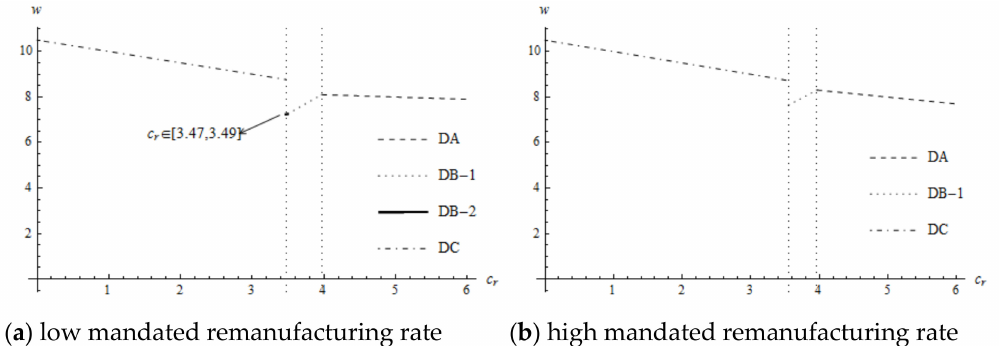
Figure 2. The impact of c r on the supplier’s wholesale price.